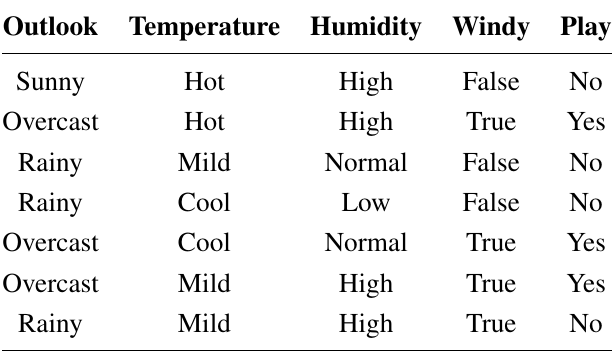
Table 1. Example of a